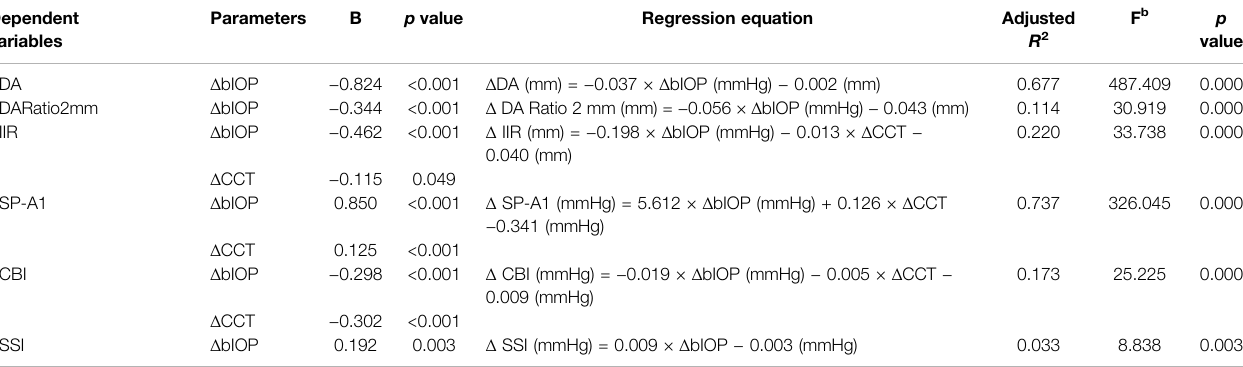
TABLE 4 | Multiple linear regression analysis results between of correlation between Δ bIOP, Δ CCT, and six DCR parameters. Dependent